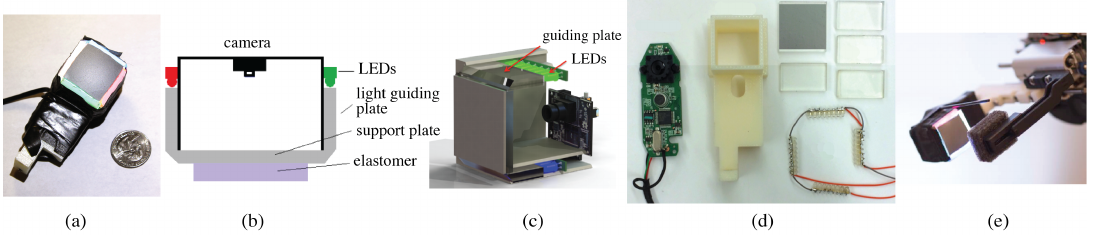
Figure 11. Fingertip GelSight sensor introduced in [28,30] (Got copyright permission from MIT and IEEE): the illumination has four colors (red, green, blue and white), and the entire sensing elastomer through the guiding plates are made of clear acrylic boards. The sensing elastomer coating in this design is the semi-specular coating. ( a ) picture of the sensor; ( b , c ) schematic of the sensor; ( d ) the parts of the sensor before assembling; ( e ) integration of the sensor into the Baxter Robot’s gripper.